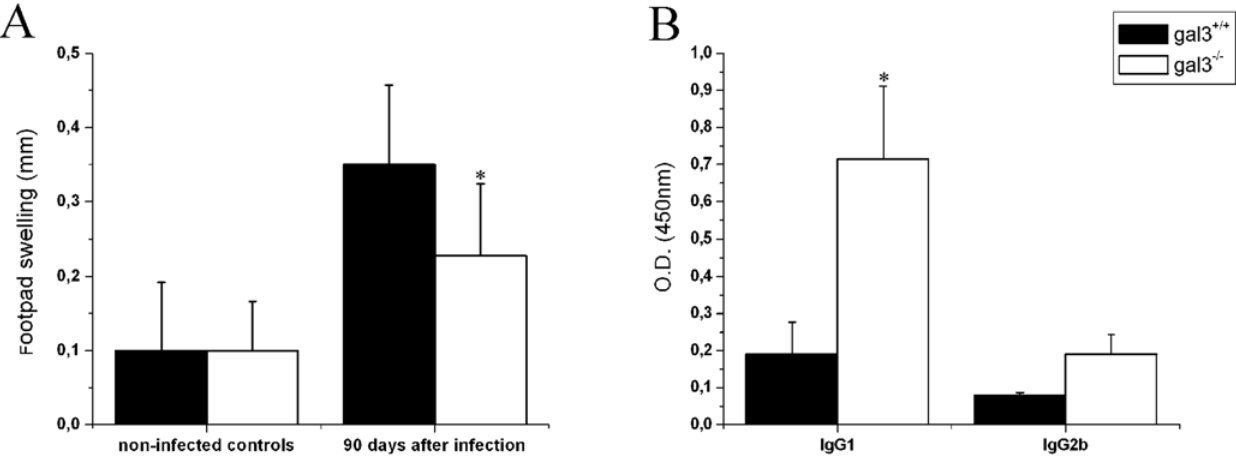
Figure 4. Cellular and humoral responses to P.brasiliensis in the absence of galectin-3. DTH reaction (A) and serum level of specific antibodies (B) of gal3 + / + (black bars) and gal3 2 / 2 (open bars) mice intraperitoneally infected with 5 6 10 6 yeasts cells. DTH reaction was assayed in groups of 8–13 mice, 90 days after infection. Each bar represents the mean 6 SD from a representative experiment of two assays. IgG1 and IgG2b levels were detected by ELISA in the sera of mice 30 days after infection. The bars represent the mean 6 SD of the O.D. obtained for sera, diluted 30 times, of five animals and are representative of two independent experiments. * P , 0.05, compared with infected gal3 + / + mice.